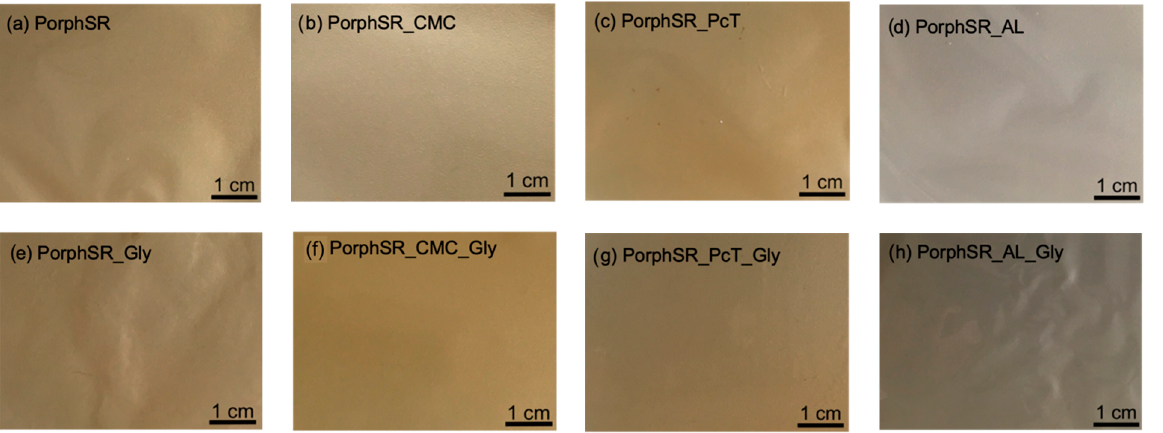
Figure 2. Macroscopic features of the produced films. Without added glycerol: ( a ) PorphSR; ( b ) PorphSR_CMC; ( c ) PorphSR_PcT; ( d ) PorphSR_AL. With added glycerol: ( e ) PorphSR_Gly; ( f ) PorphSR_CMC_Gly; ( g ) PorphSR_PcT_Gly; ( h ) PorphSR_AL_Gly.